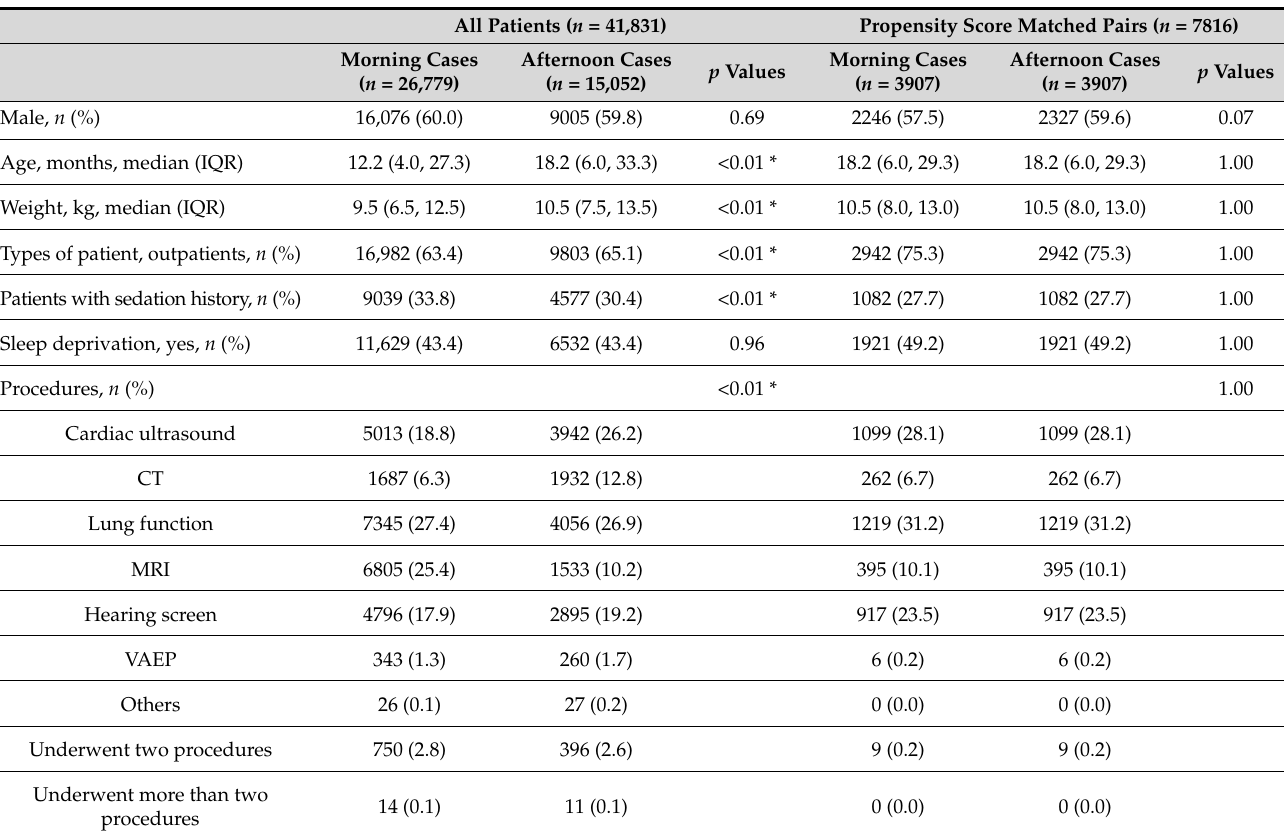
Table 1. The demographic characteristics of the two cohorts.